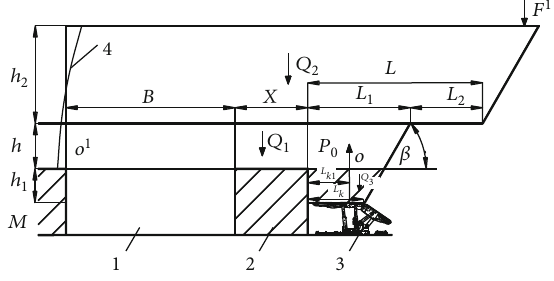
Figure 10: Support load calculation chart. 1 — abandoned roadway, 2 — coal, 3 — working face, 4 — fracture